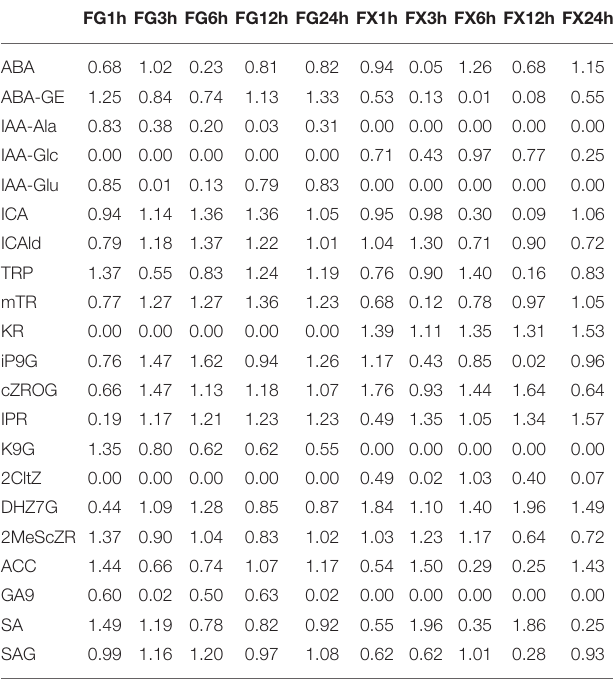
TABLE 3 | Variable important for the projection (VIP) of plant hormone components in orthogonal partial least squares discriminant analysis